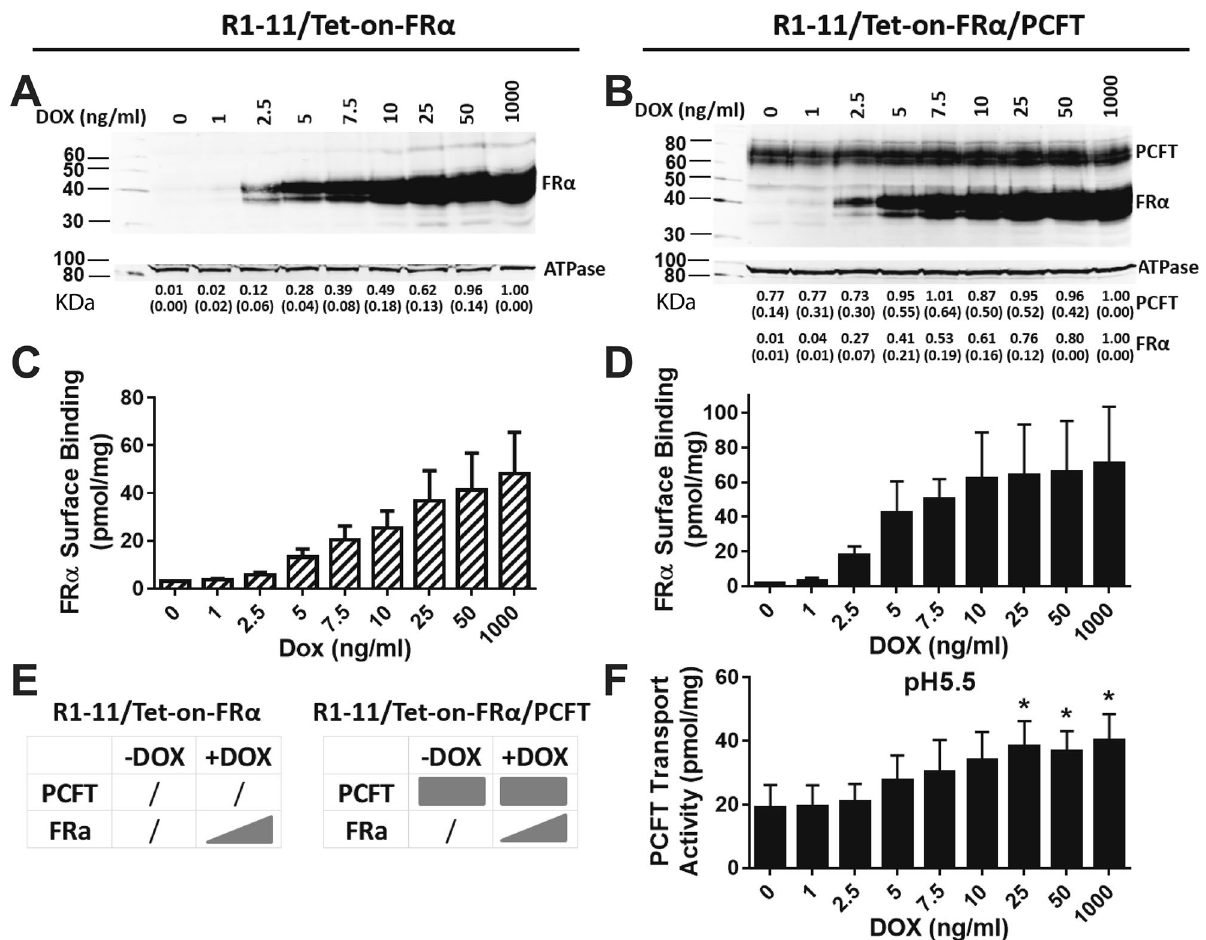
Figure 2. Characterization of R1-11/Tet-on-FRα single and R1-11/Tet-on-FRα/PCFT double transfectant models. R1-11/Tet-on-FRα or R1-11/Tet-on-FRα/PCFT cells were plated in 60-mm dishes in complete folate- free (FF) RPMI 1640 medium containing 10% fetal bovine serum (FBS) for transport/binding and protein expression assays. Twenty-four hours later, a range of DOX (0, 1, 2.5, 5, 7.5, 10, 25, 50, and 1000 ng/ml) was added. After 48 h, FRα and/or PCFT protein levels for the R1-11/Tet-on-FRα single ( A ) or R1-11/Tet-on-FRα/ PCFT double ( B ) models were measured in crude plasma membranes by SDS-PAGE and Western blotting with a HA monoclonal antibody (upper panels) followed by stripping and re-probing with Na + /K + ATPase monoclonal antibody (lower panels) as a loading control. Blots were cropped as needed. The full blots are included in the Supplement (Figs. S2–S5). The molecular mass markers for SDS-PAGE are noted. Densitometry was performed using Odyssey software, and FRα or PCFT protein levels were normalized to those for Na + / K + ATPase and expressed relative to the level at the maximum concentration of DOX. Densitometry results are summarized below the individual lanes and are presented as mean values plus/minus standard deviations (SDs; in parenthesis) from at least 3 experiments. FRα levels ( C , D ) were also determined with [ 3 H]FA at 0 °C for 15 min; PCFT uptake ( F ) was measured with [ 3 H]MTX at pH 5.5 at 37 °C for 2 min. Results are presented as mean values plus/minus SDs from at least 3 experiments. The statistical significance of PCFT transport activities between samples with and without DOX was analyzed by an unpaired t test. An asterisk indicates a statistically significant difference between the mean transport values ( p < 0.05). A schematic is shown depicting the patterns of expression of FRα in R1-11/Tet-on-FRα cells, and of FRα and/or PCFT in R1-11/Tet-on-FRα/PCFT cells, in the presence or absence of DOX ( E